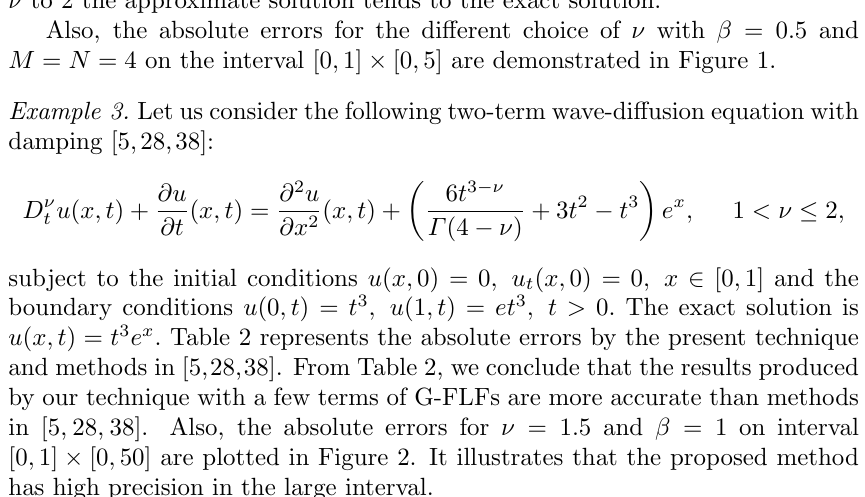
present example. From Table 1, it is clear that with approaching the values of ν to 2 the approximate solution tends to the exact